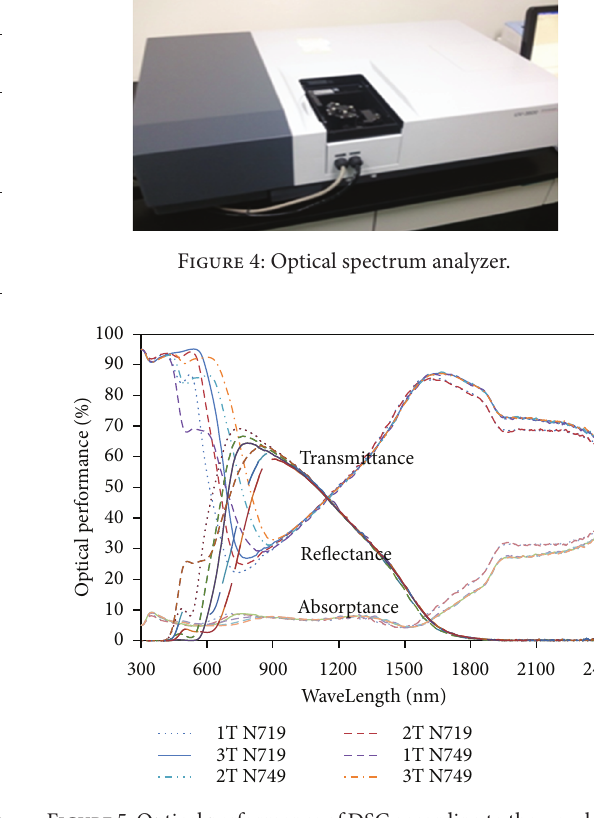
Figure 5: Optical performance of DSC according to the